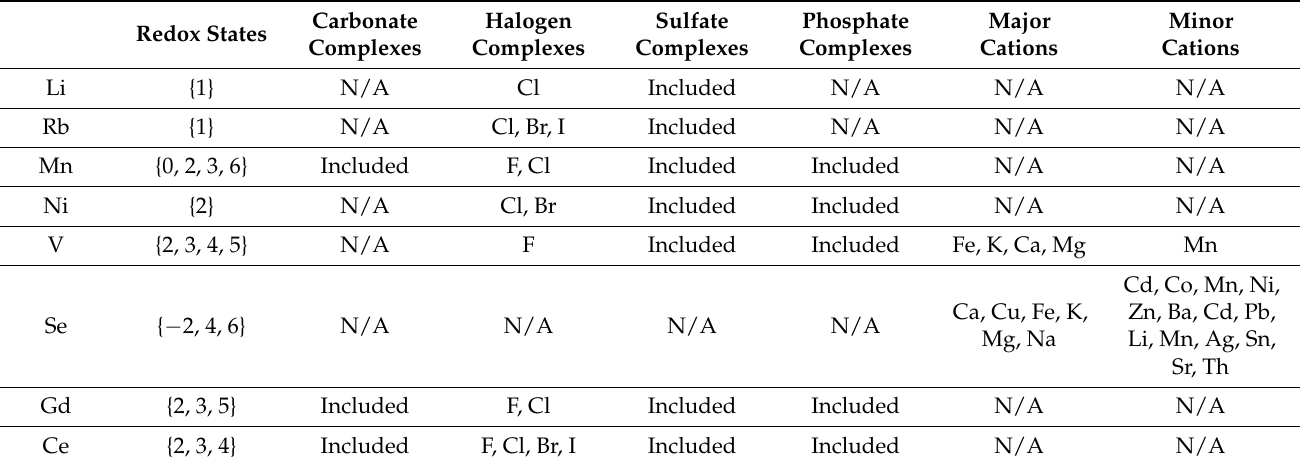
Table 1. Aqueous speciation coverage in the modified database for select trace